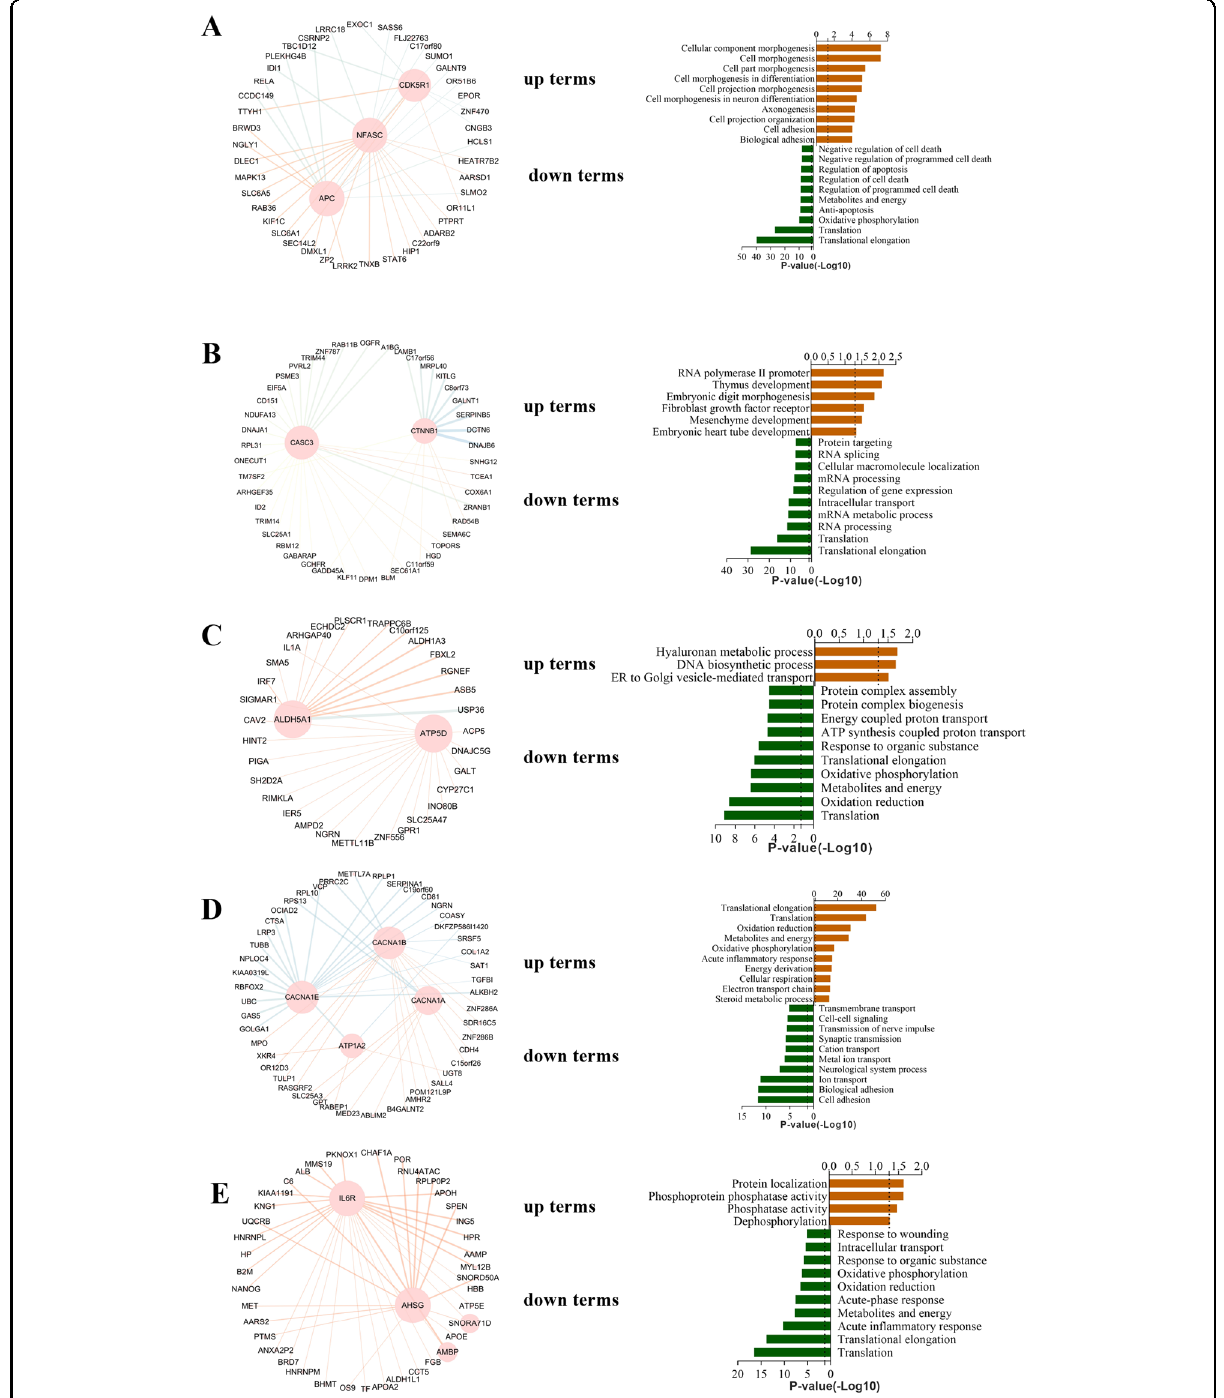
Fig. 3 Hub-gene co-network and functional annotation of HCC0 – 4 (clusters 0 – 4). A Hub-gene co-network and GOBP functional analysis of HCC0 (cluster 0). B Hub-gene co-network and GOBP functional analysis of HCC1 (cluster 1). C Hub-gene network and GOBP functional analysis of HCC2 (cluster 2). D Hub-gene network and GOBP functional analysis of HCC3 (cluster 3). E Hub-gene network and GOBP functional analysis of HCC4 (cluster